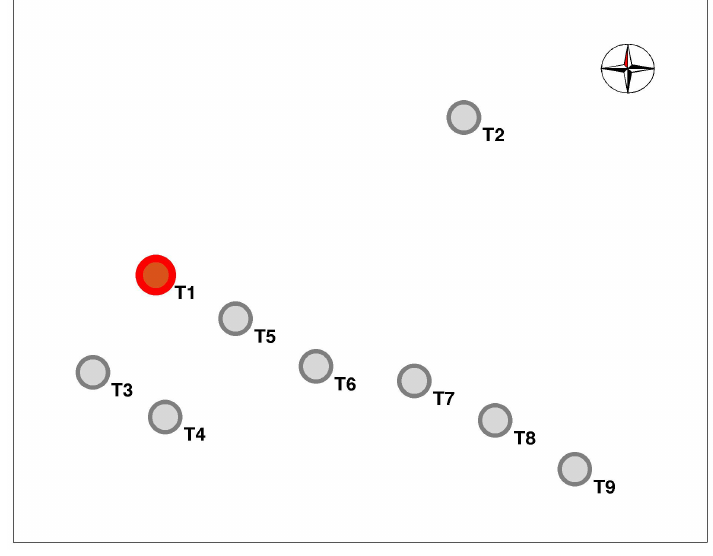
Figure 1. The layout of the wind farm. Table 1. Inter-turbine distances in rotor